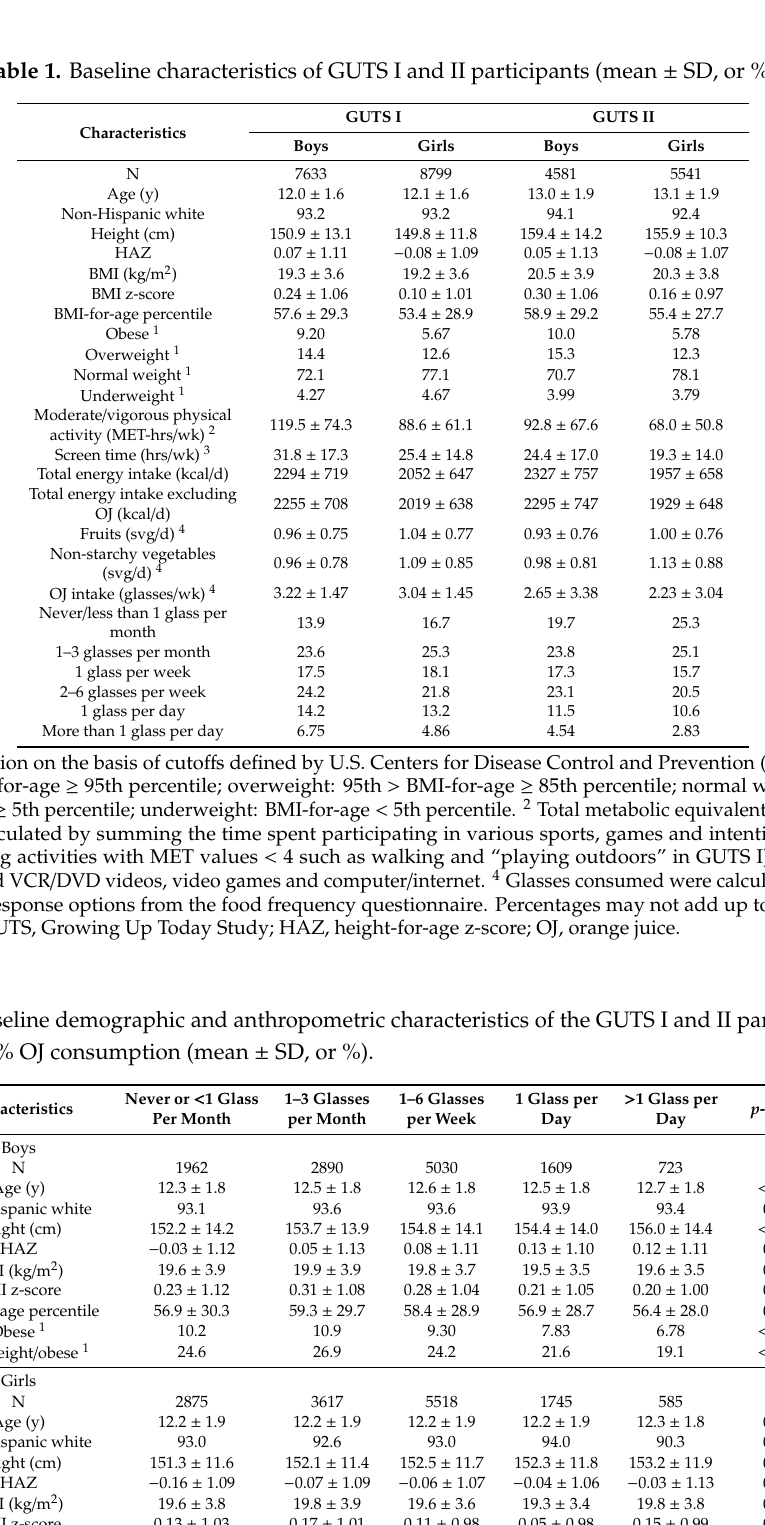
Table 1. Baseline characteristics of GUTS I and II participants (mean ± SD, or %).